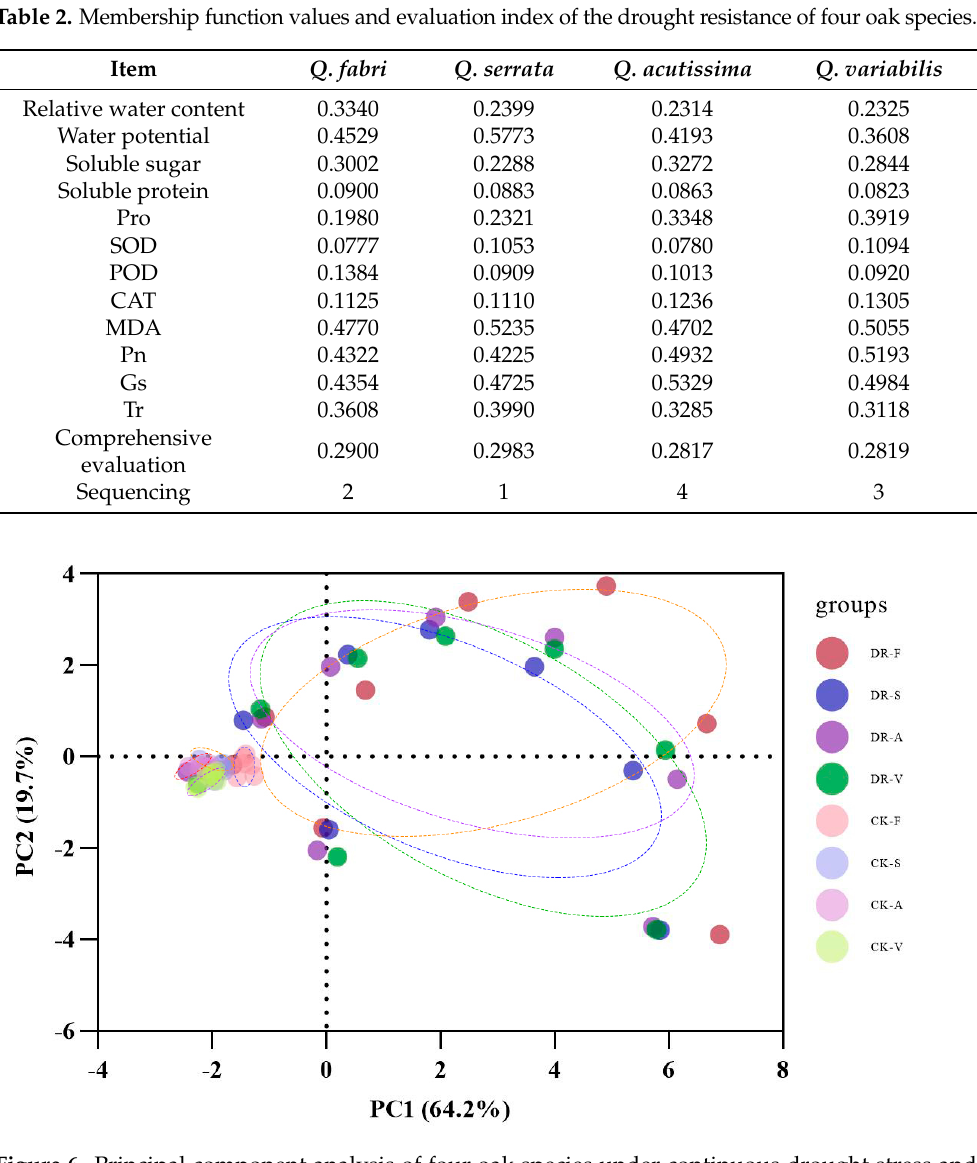
Figure 6. Principal component analysis of four oak species under continuous drought stress and